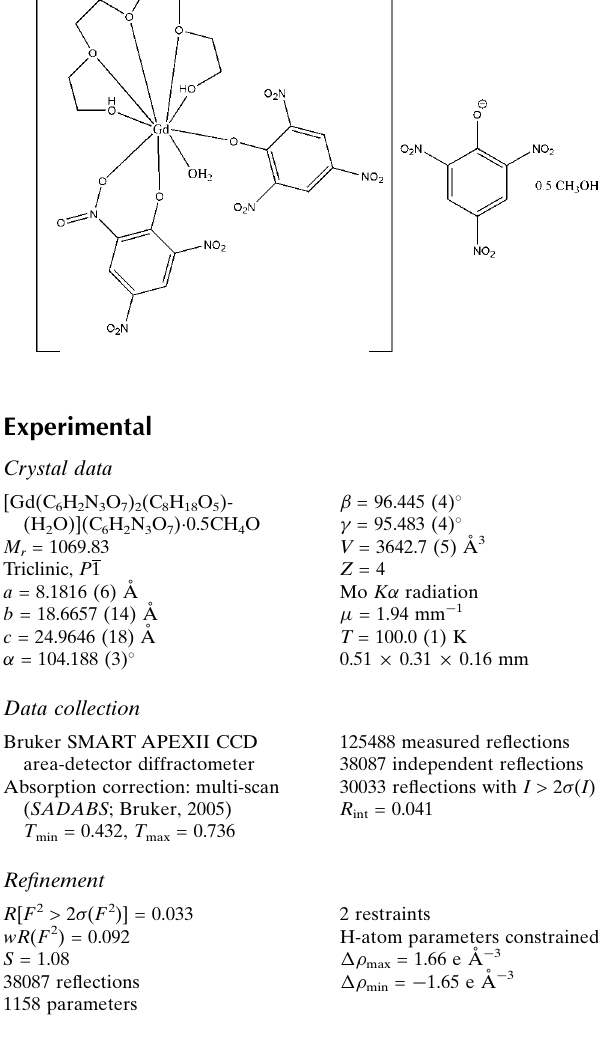
Key indicators: single-crystal X-ray study; T = 100 K; mean (cid:1) (C–C) = 0.003 A˚; disorder in solvent or counterion; R factor = 0.034; wR factor = 0.093; data-to- parameter ratio = 32.9.